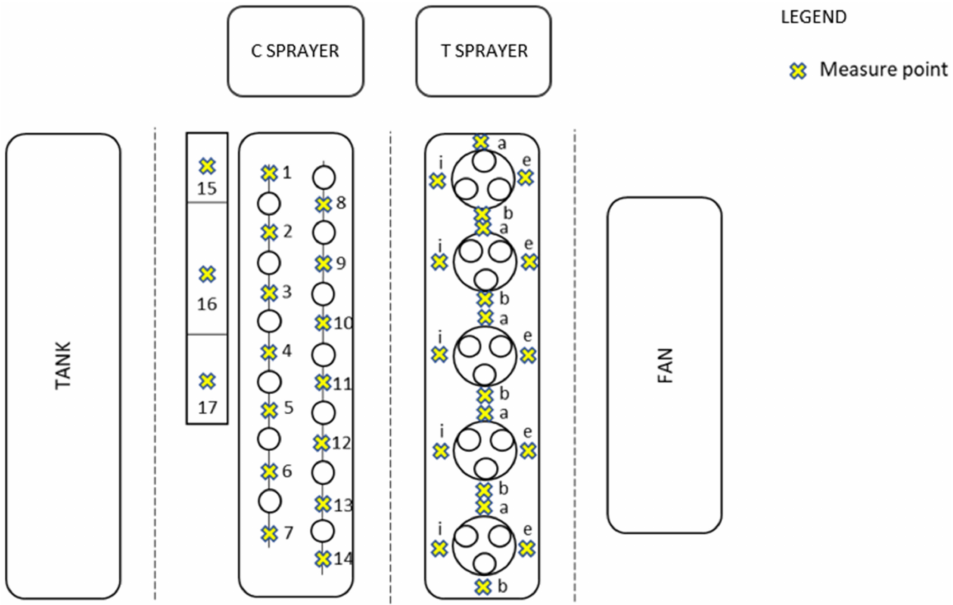
Figure 5. Points of measurement of air speed in the sprayers used. In the T sprayer the letters indicate a: top; b: down; i: inside; e: